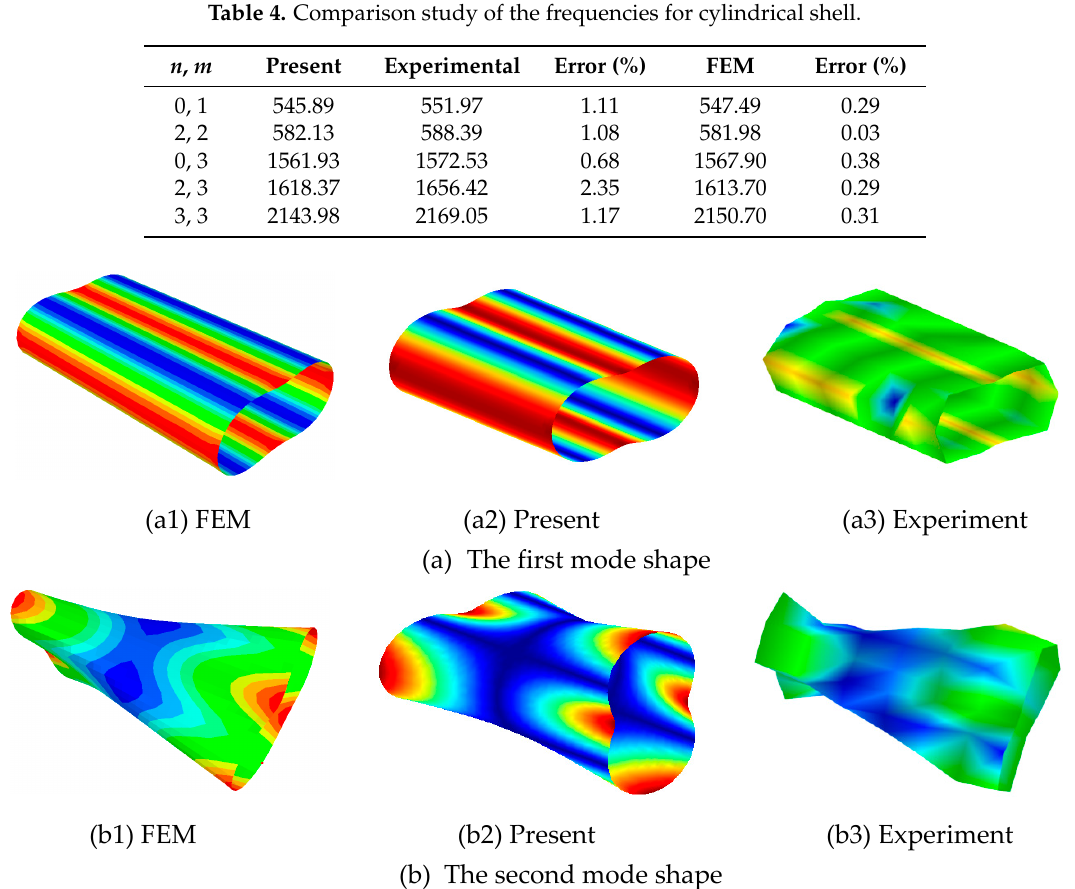
Figure 8. The selected mode shapes of three kinds of method.